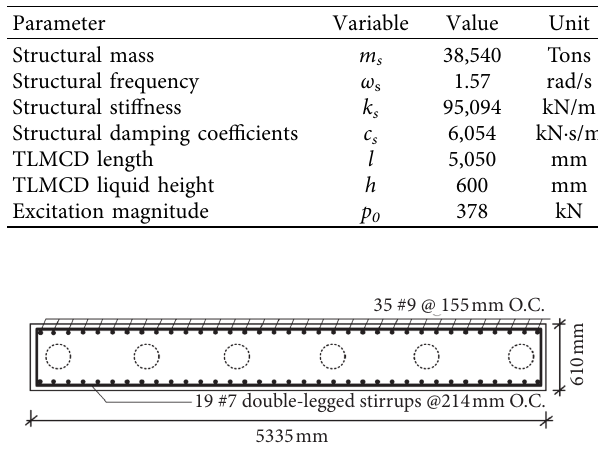
Figure 4: Schematic of the SDOF system equipped with a Table 2: Properties of the SDOF system.